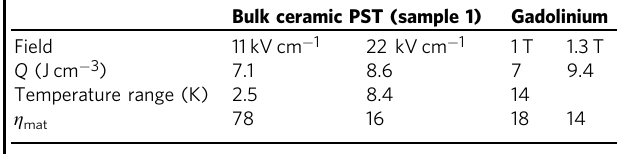
Table 2 Comparison of materials ef fi ciency of PST with